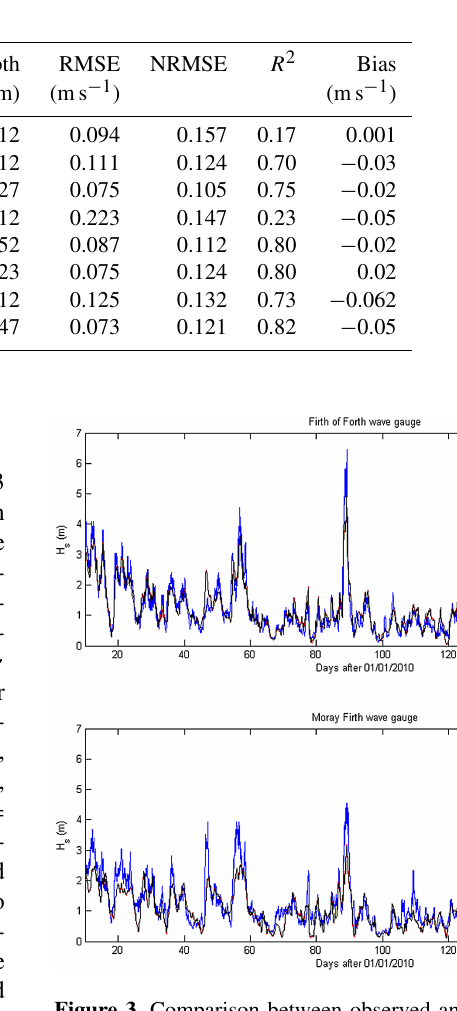
Figure 3. Comparison between observed and modelled H s in the Firth of Forth and the Moray Firth for